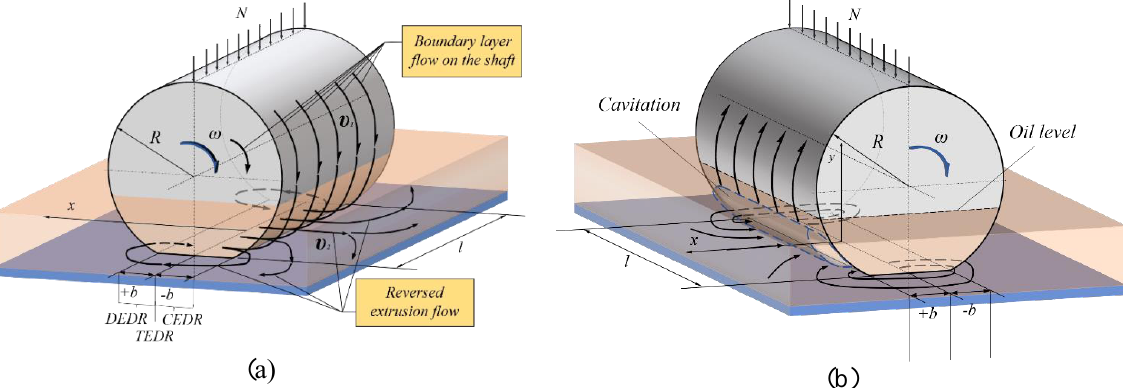
Fig. 2. Scheme of the occurrence of extrusion and reverse flows in the convergent non-contact and elastically deformed regions (a) as well as rarefaction in the divergent non-contact and elastically deformed regions (b) of the tribocontact according to the Timken